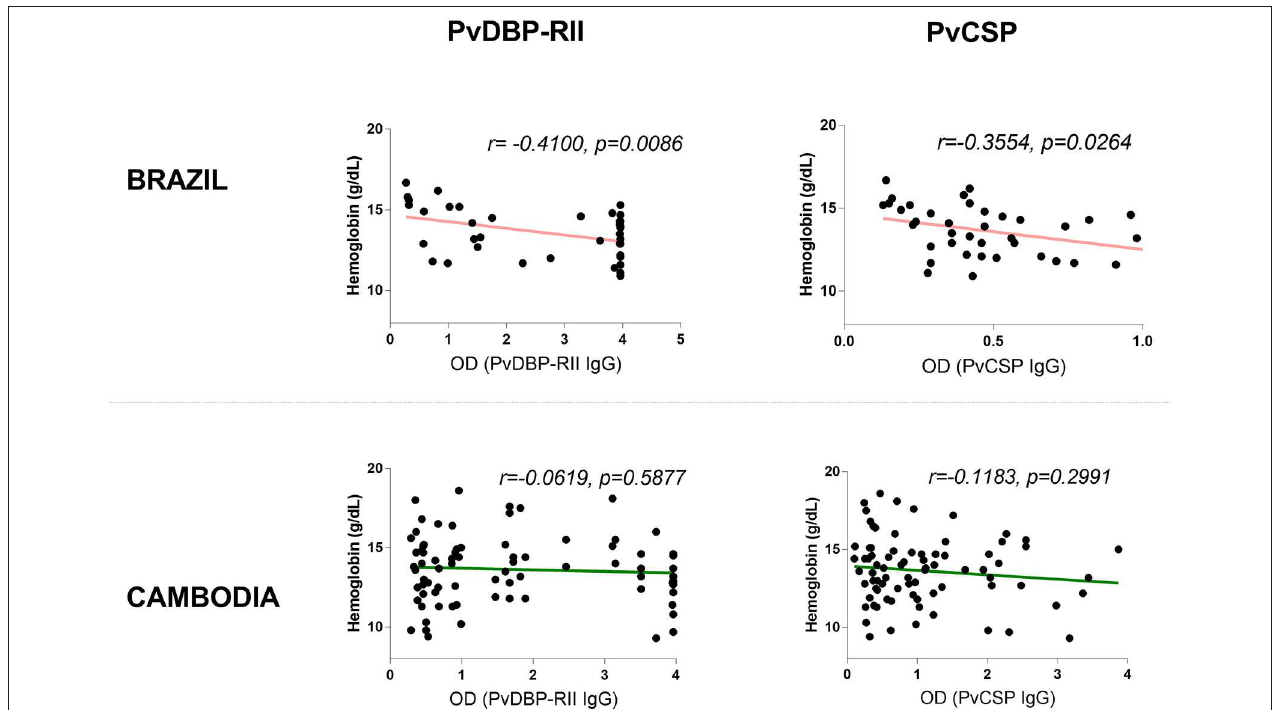
FIGURE 8 | Correlation between antibodies elicited in response to blood-stage antigen (PvDBP-RII) or sporozoite-stage antigen (PvCSP) and hemoglobin levels in Brazil and Cambodia.